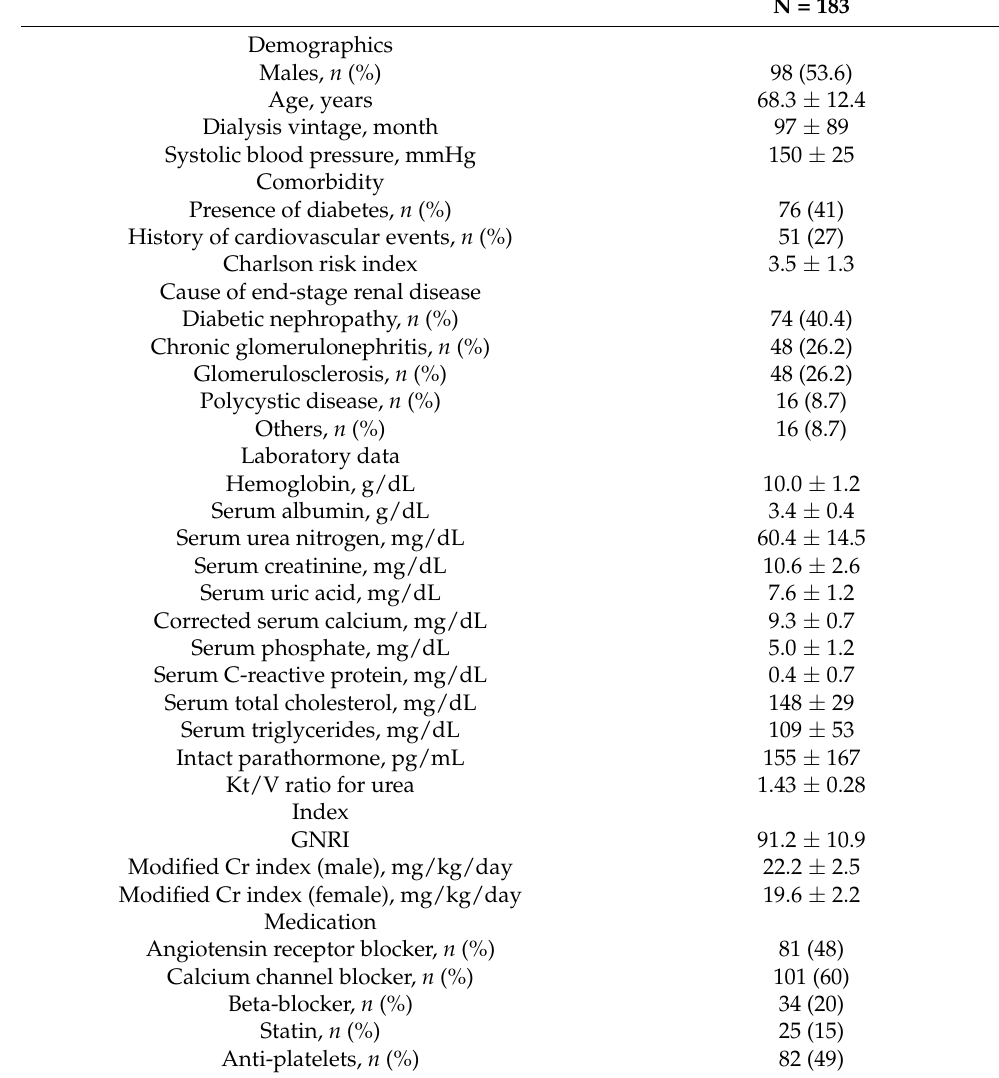
Table 1. Baseline